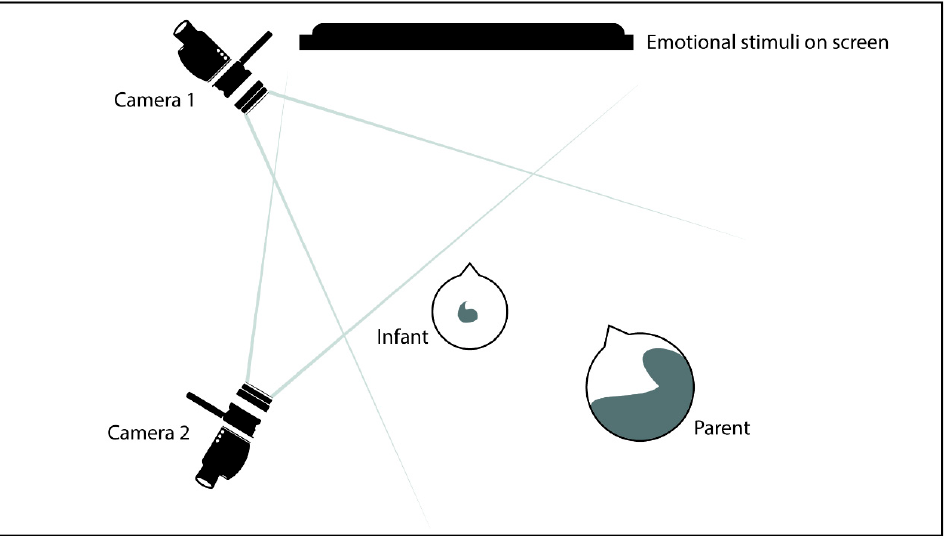
Figure 1. Triadic setting.